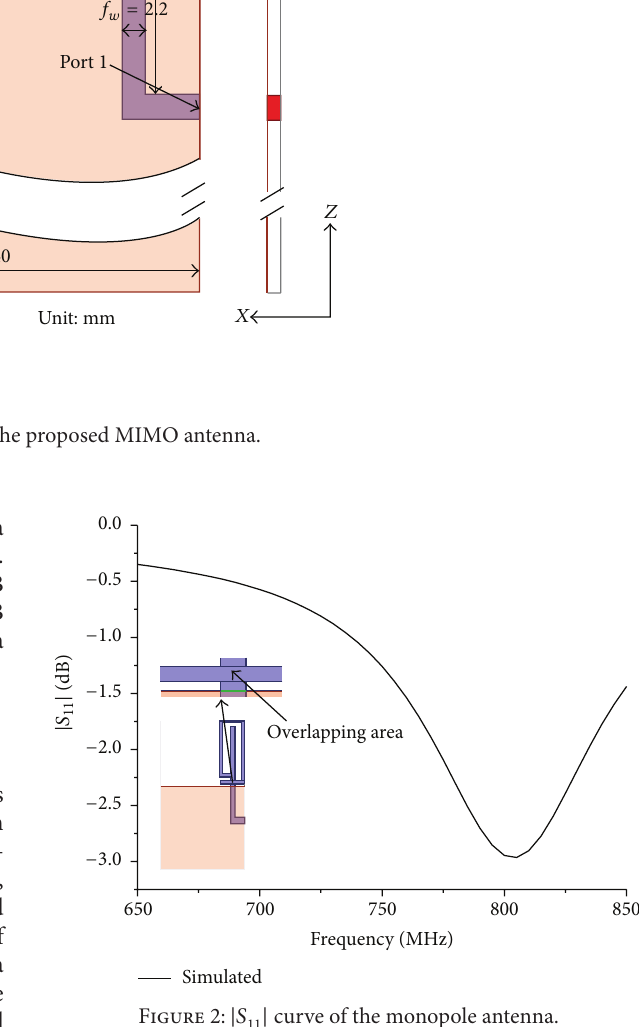
Figure 2: |𝑆 11 | curve of the monopole